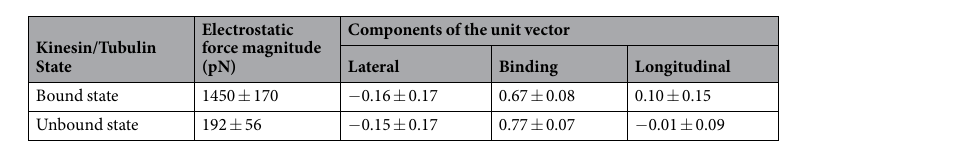
Table 2. Mean electrostatic force magnitude and direction. Note: Values are reported as mean ± standard error of the mean; n = 10 wild type kinesin